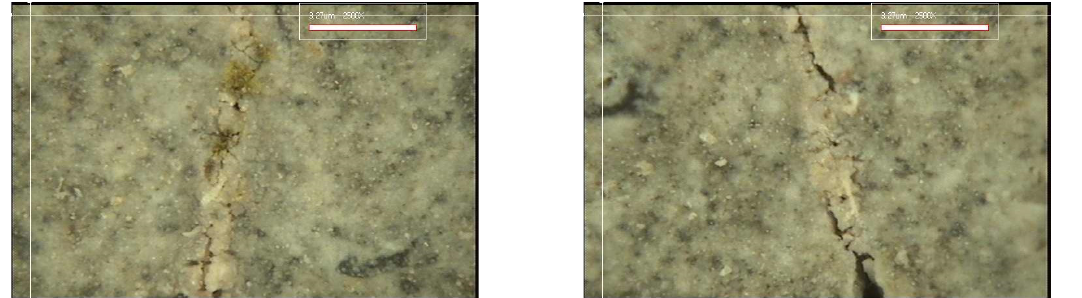
Figure 18. Surface crack monitoring of MCs 1%.